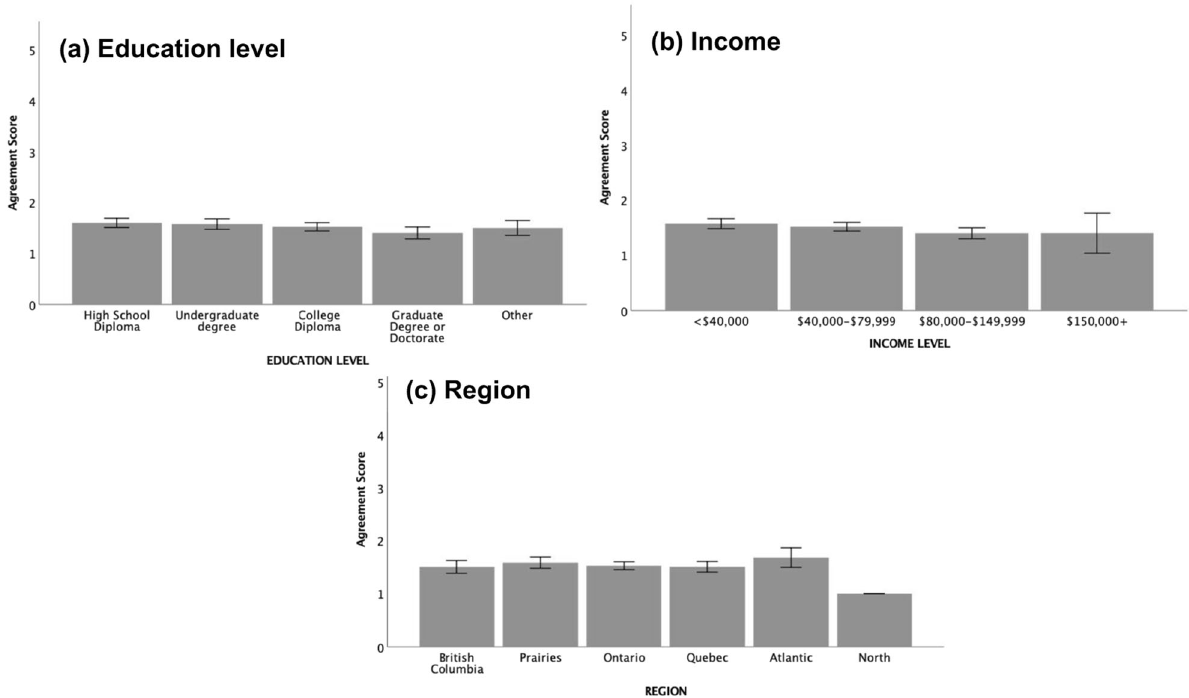
Fig. 7 Consumer opinion on further education needed to reduce single-use plastic consumption by education, income, and region. Panels indicate education ( a ), income ( b ), and region ( c ). Error bars indicate standard